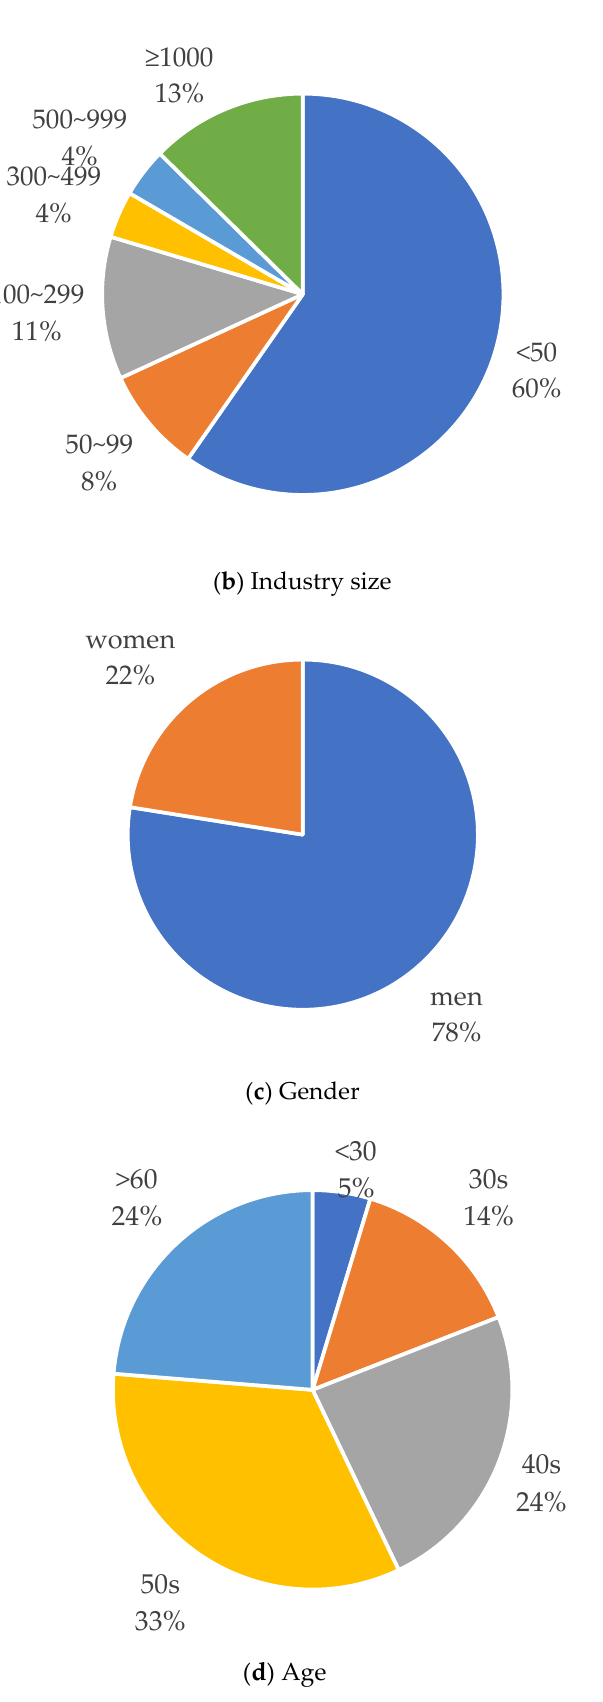
Figure 6. Distribution of WMSDs by industry type and size and workers ’ gender and age. The percentage or number of WMSD cases was almost 3.5 times higher in men (78%) than that in women (22%) (Figure 6c). Workers aged > 50 years accounted for more than half of total WMSDs (57%), while young and middle-aged workers < 40 years occupied less than 20% of WMSDs (19%) (Figure 6d).